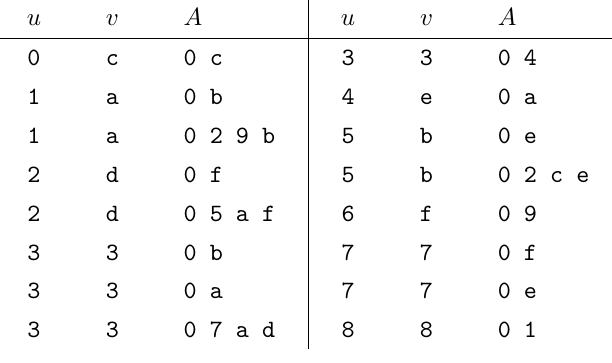
Table 3: Affine invariant subspaces for Sb